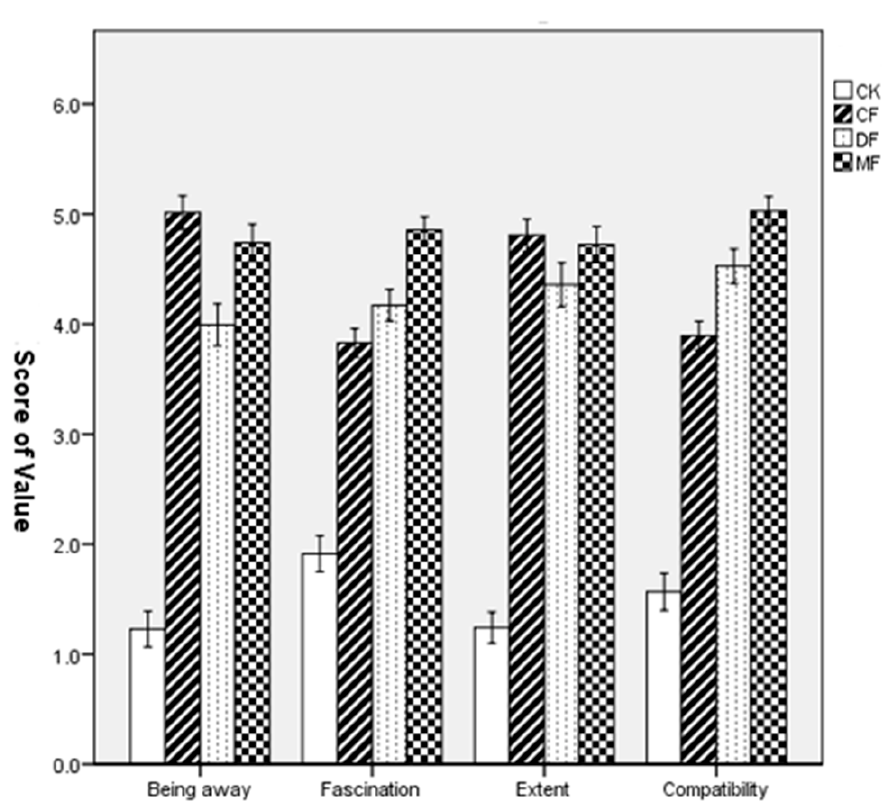
Figure 4. Comparison of the dimensional scores of PRS in four environmental sites. Data are presented as the means ± SEs. CK = city site, CF = coniferous forest, DF = deciduous forest, MF = mixed forest.